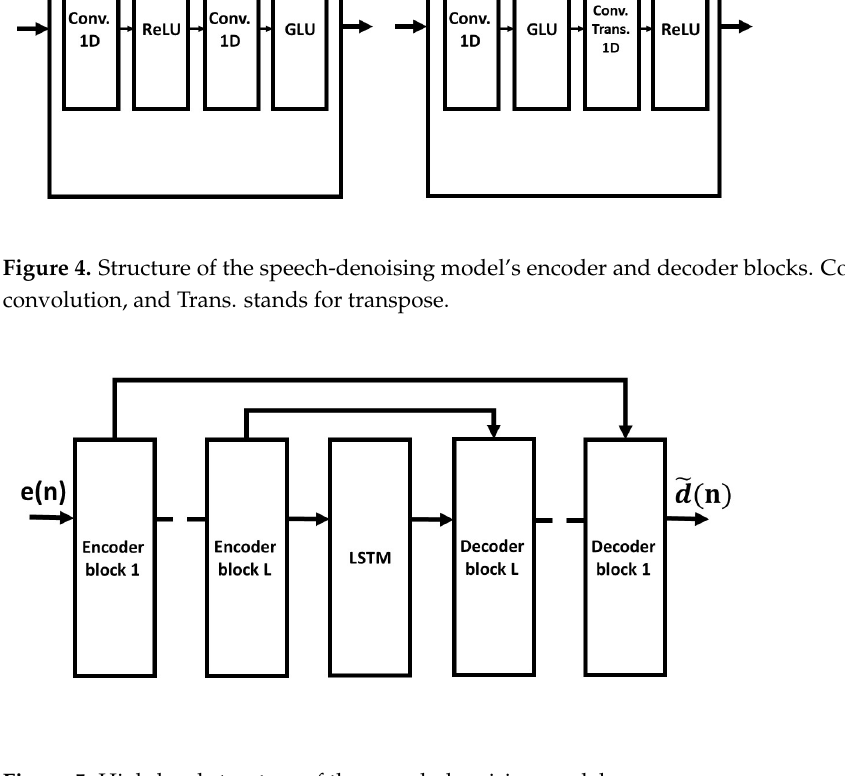
Figure 5. High-level structure of the speech denoising